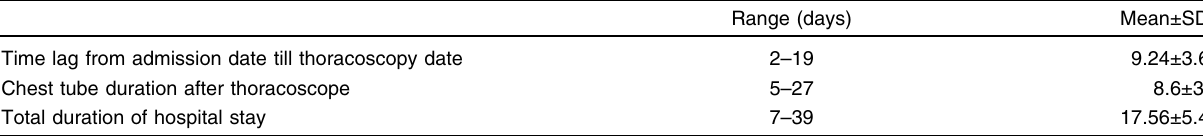
Table 8 Duration of patient hospital stay